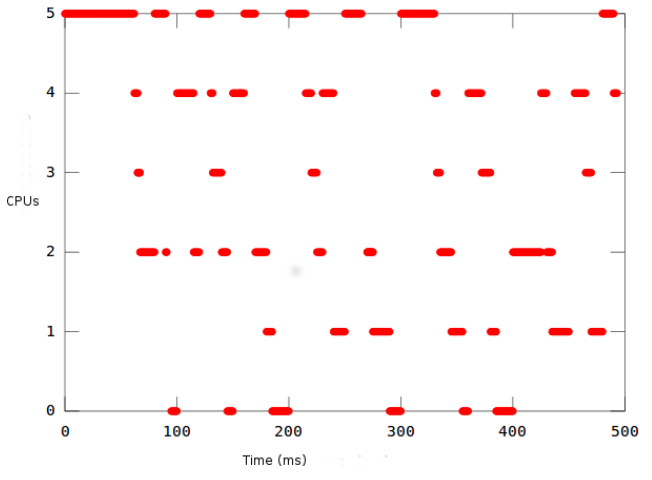
Figure 9. Evolution of the Number of Active